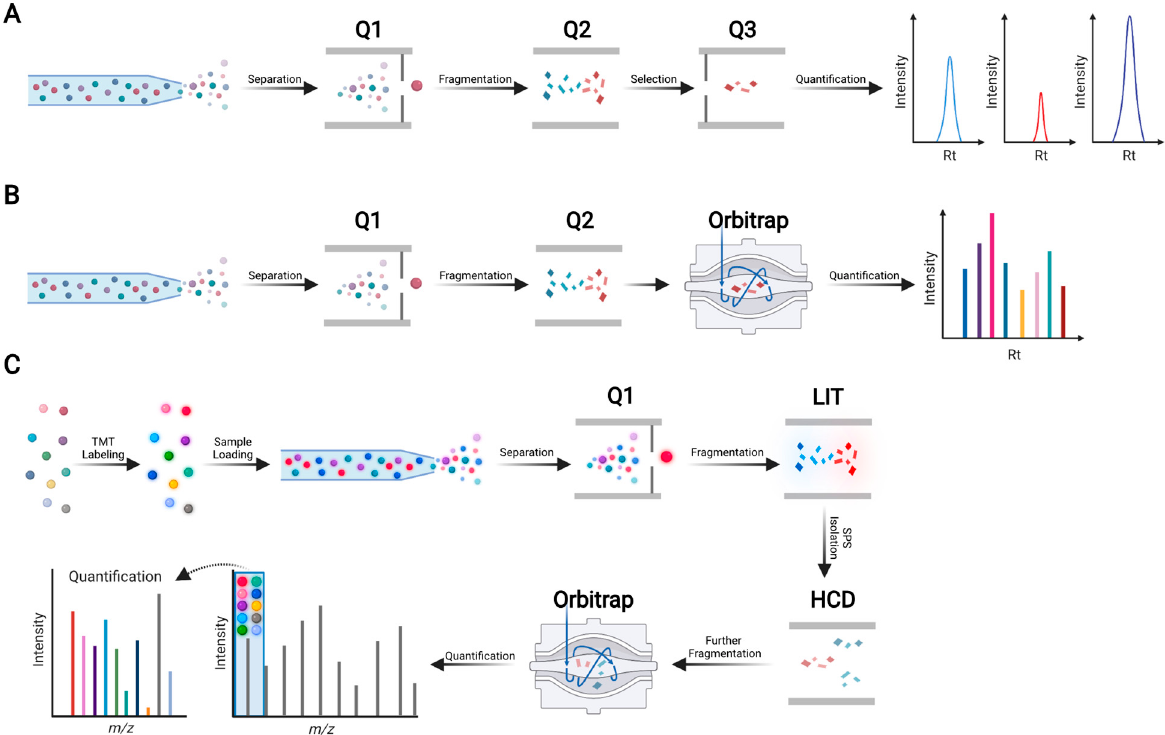
Figure 7. Schematic overview of MS-based targeted proteomics methods. ( A ) Schematic of selected reaction monitoring (SRM), also known as multiple reaction monitoring (MRM). For peptide quantification, three to five selected fragment ions from a single peptide precursor ion are measured sequentially. SRM is typically performed on a triple quadrupole (QqQ) mass spectrometer. The first quadrupole (Q1) isolates a predefined peptide precursor ion, the second quadrupole (Q2) is a collision cell where isolated precursor ions are broken into product ions (also called fragment ions), and the third quadrupole (Q3) isolates predefined product ions. Such predefined pairs of precursor and product ions are called transitions, which provide high specificity and sensitivity to quantify peptides that are surrogates of proteins of interest. ( B ) Schematic of parallel monitoring reaction (PRM). PRM employs a high-resolution Orbitrap mass analyzer to simultaneously monitor many product ions. Because transitions do not need to be defined in advance, PRM is easier to set up than SRM. ( C ) Schematic of TOMAHAQ (triggers by offset, multiplexed, accurate mass, high-resolution, absolute quantification). Peptides derived from 10 (or 16) samples are labeled with 10-plex (or 16-plex) tandem mass tag (TMT) reagents, which consist of 10 (or 16) different isobaric compounds with the same mass and chemical structure. Subsequently, an equal amount of differentially TMT-labeled peptides is pooled into one tube, followed by LC separation and targeted MS analysis. Rt: retention time; LIT: linear ion trap; HCD: higher-energy collisional dissociation.